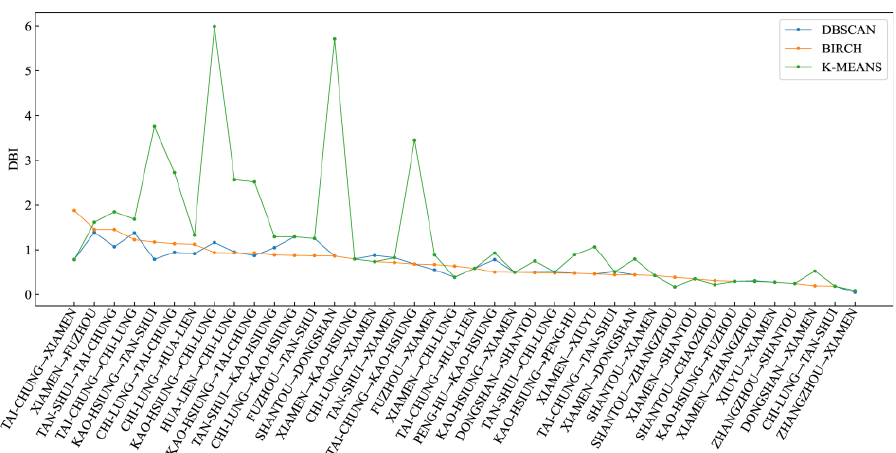
Figure 13. Comparison of SC evaluation indices for different clustering algorithms.